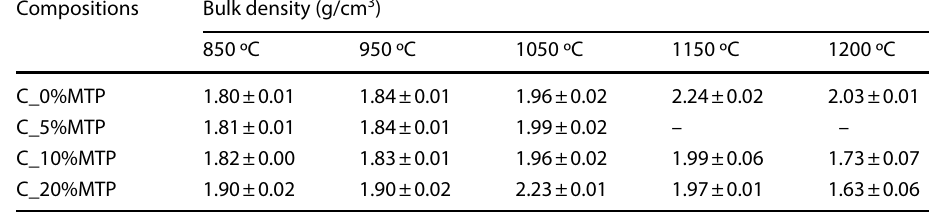
Table 8 Bulk density behavior with the increase of firing